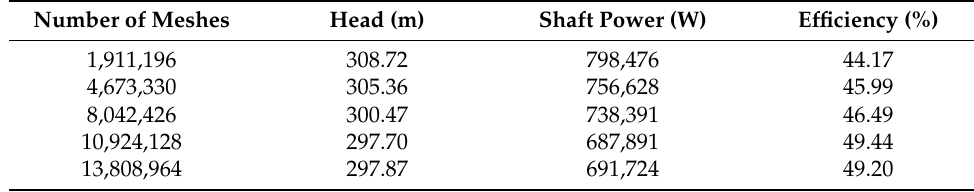
Table 2. Grid independency